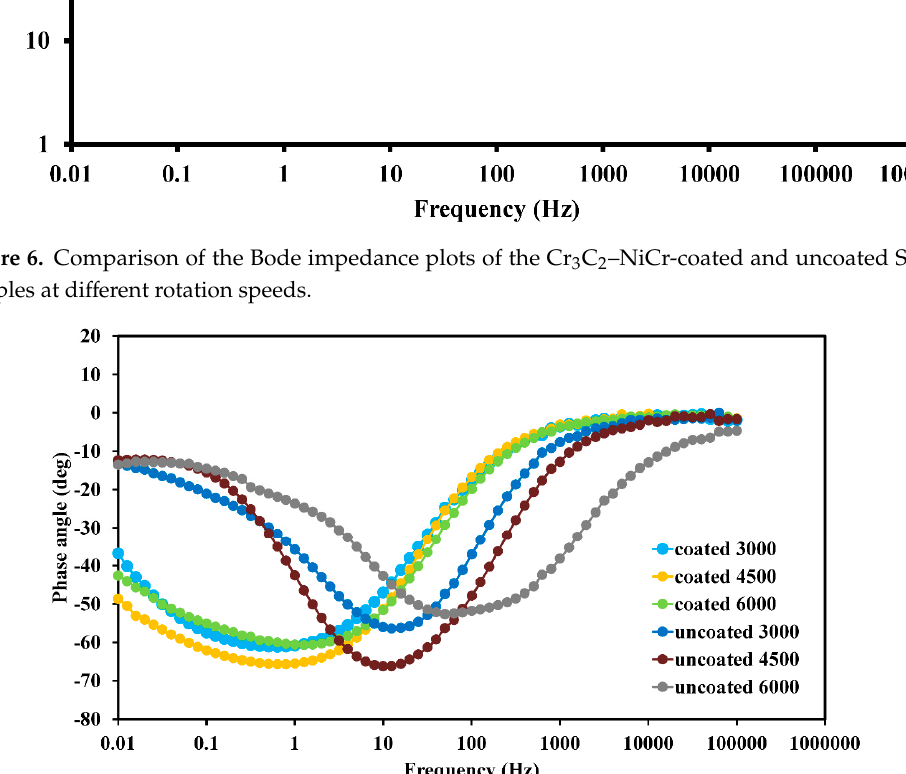
Figure 8. Comparison of the Nyquist plot of the Cr 3 C 2 –NiCr ‐ coated and uncoated SS316 samples at different rotation speeds. Figure 9. Electrical equivalent circuit model for fitting the EIS results.